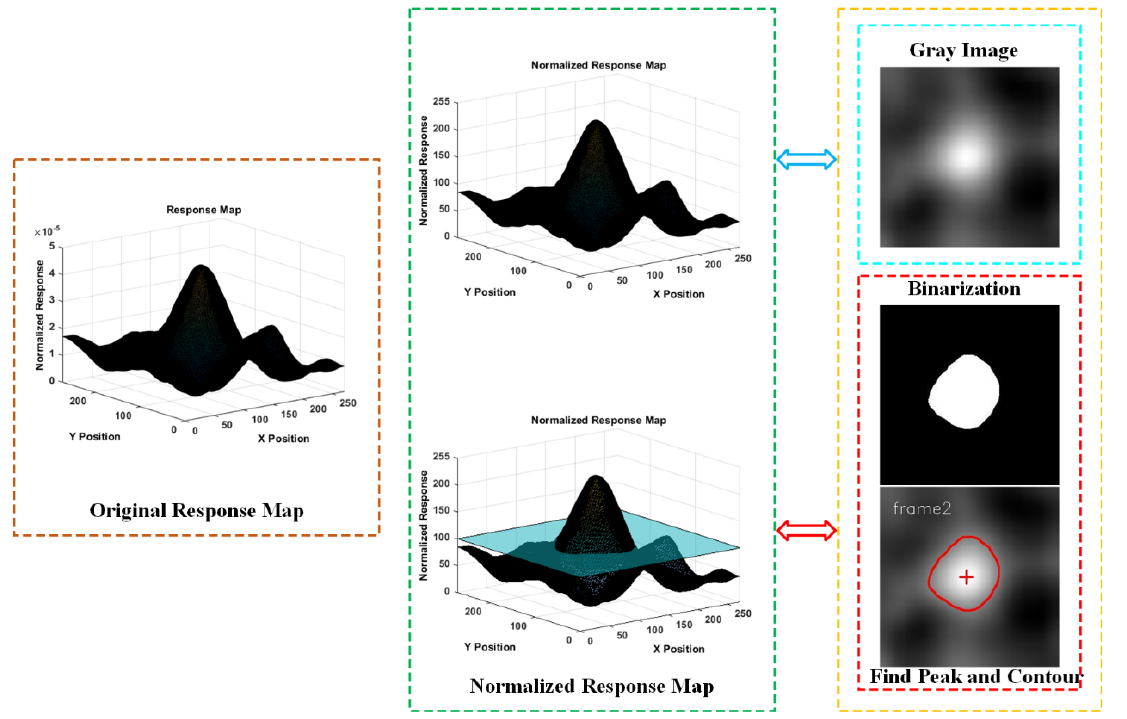
Figure 4. Illustrations of response isohypse contour.